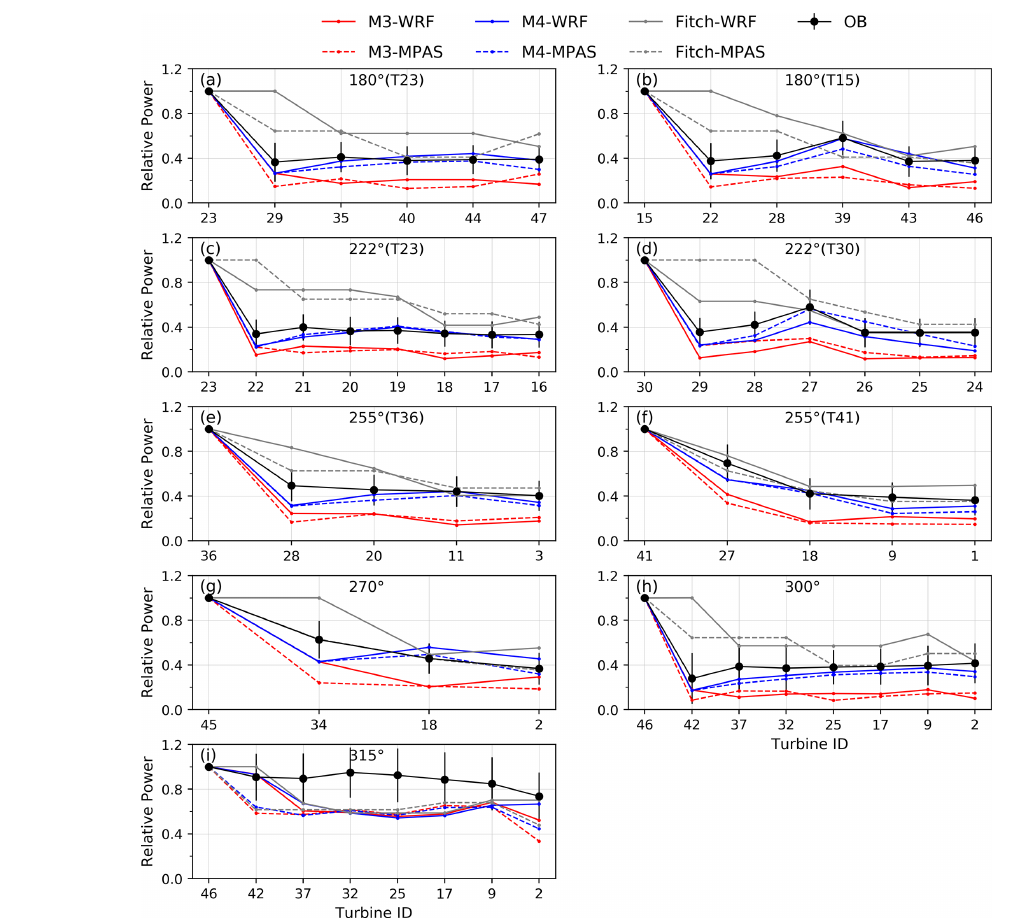
Figure 7. Same as Fig. 4 but for Lillgrund multi-cell cases with (cid:49)x =